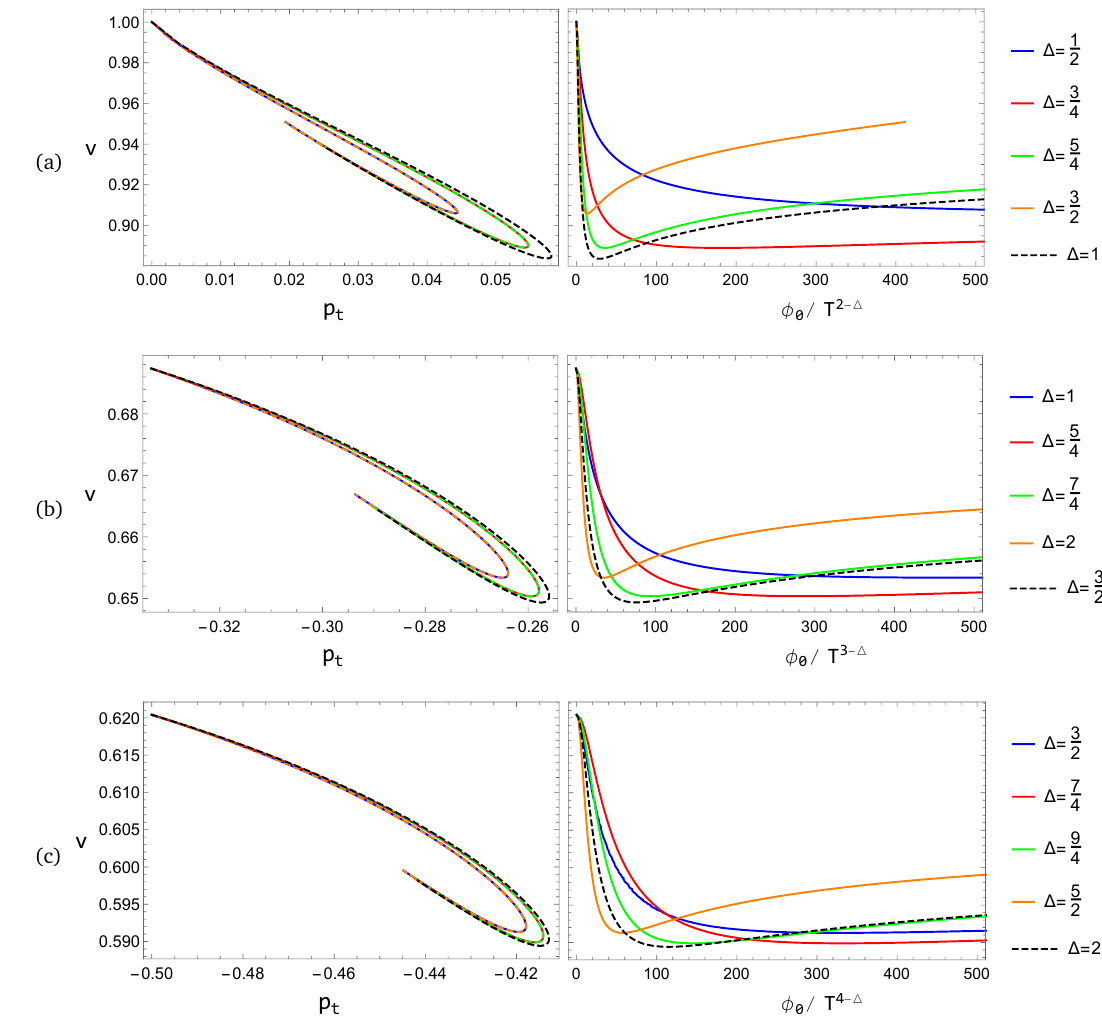
/ T d − ∆ for (a) d = 2, and φ t 0